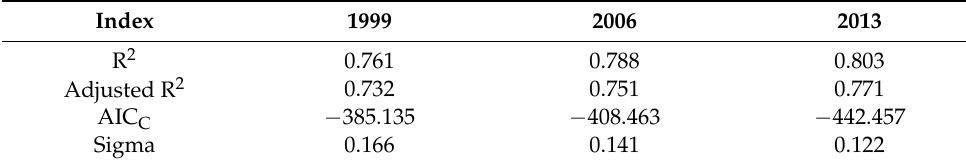
Table 3. GWR model estimation